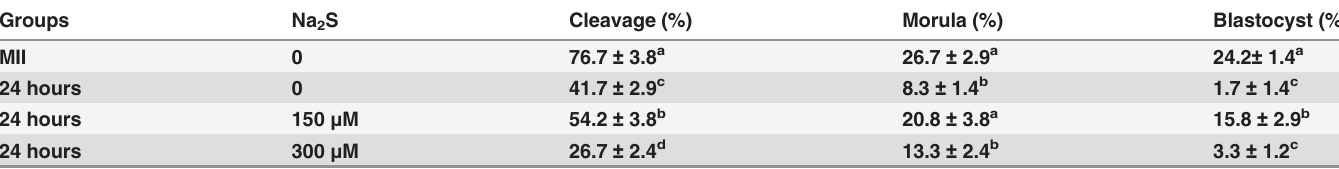
Table 2. Early embryonic development of parthenogenetically activated oocytes aged under the effect of the H 2 S donor.